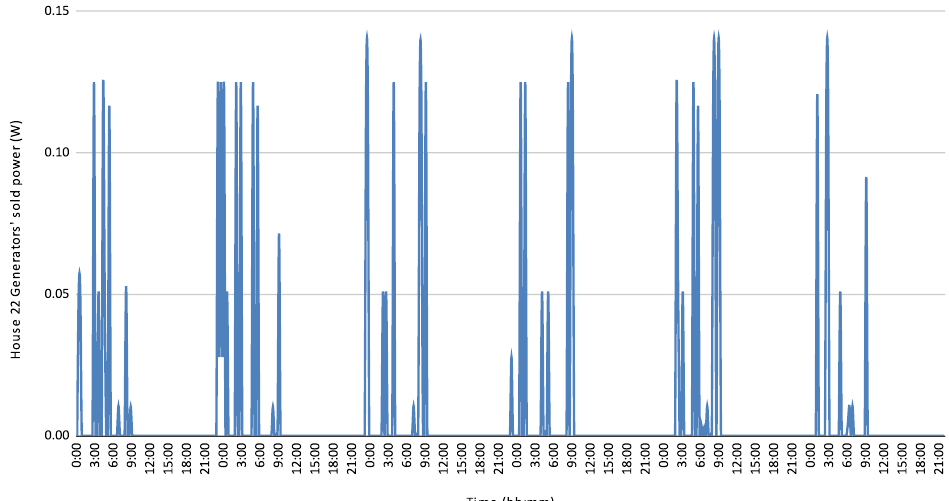
Figure 9. House 22 generator’s traded power during simulation in